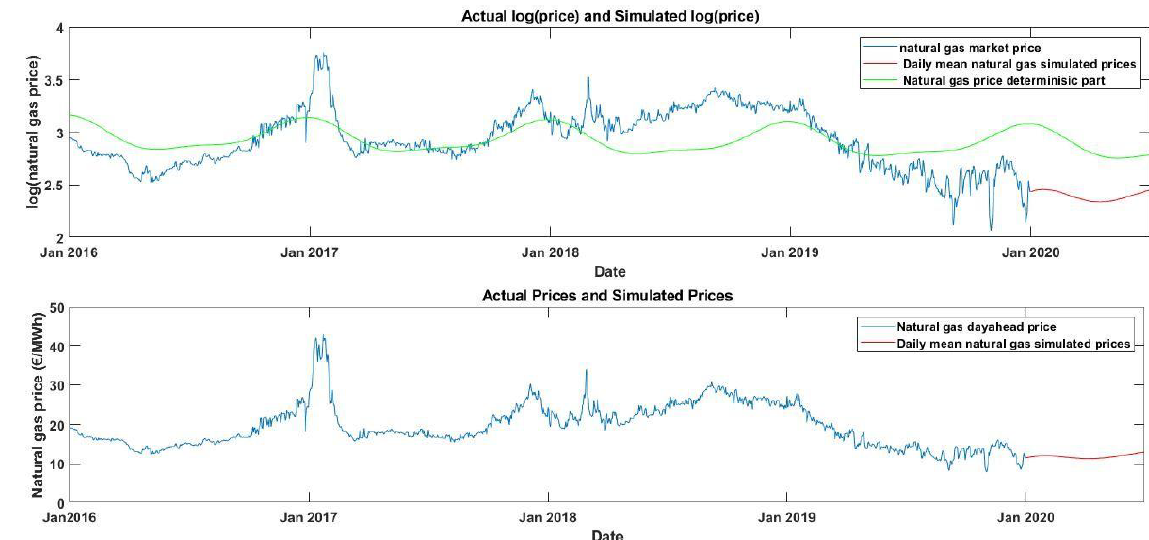
Figure 7. Daily natural logarithm of Spanish natural gas prices from 2016 to 2019 and daily mean of simulated prices for the first half-year of 2020.